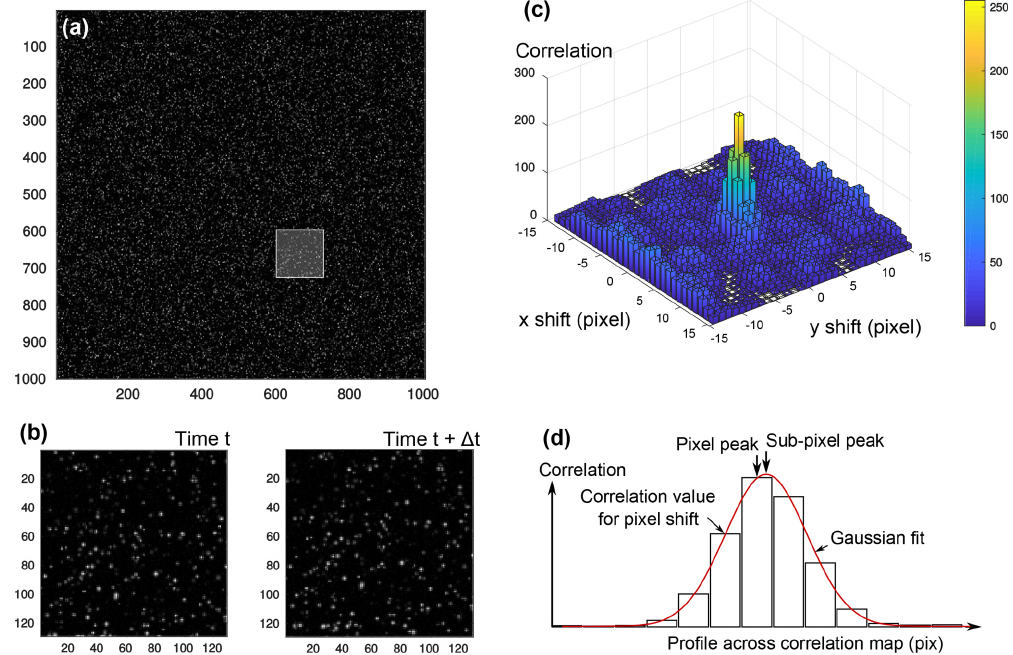
Figure 1. Principles of PIV. (a) Preprocessed image at time t with illuminated particles; (b) images at time t and t + (cid:49)t are split into small interrogation windows (here 128 pixels), and the interrogation windows are cross-correlated; (c) correlation yields a map, indicating how well the interrogation windows correlate with each other when shifted along x and y axes of the image space (here interrogation windows were 32 pixels wide); (d) the peak of the correlation map is precisely (i.e. sub-pixel) located using a Gaussian